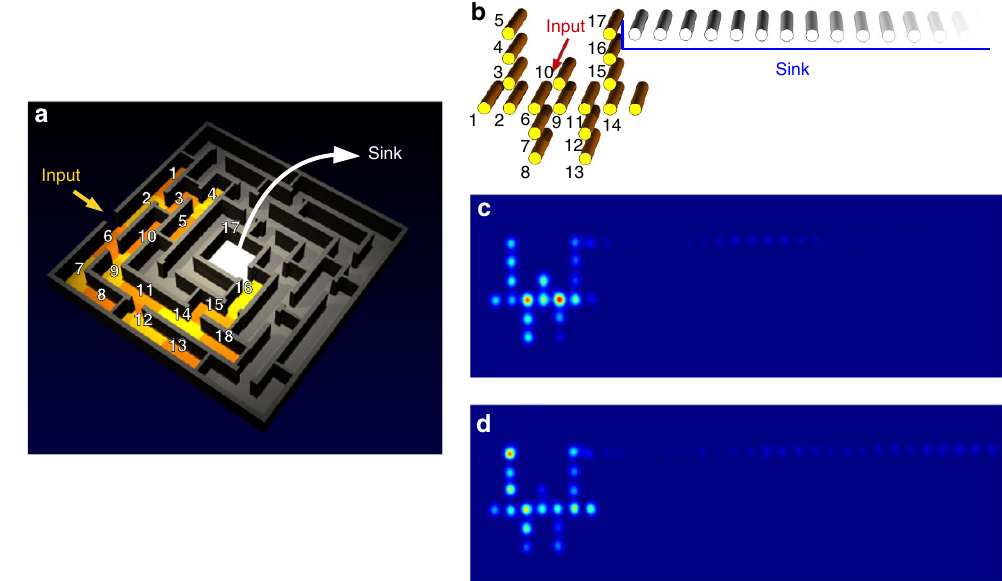
Figure 3 | Implementing the maze. ( a ) Maze structure that is experimentally implemented; ( b ) unfolding of the maze into an almost linear graph, where each node is represented by a wave guide; ( c , d ) snapshots of the light diffusion for uniform ( c ) and noisy structure ( d ). The latter pictures correspond both to a propagation length of 60mm. The noisy configuration is noise 3 in Fig.